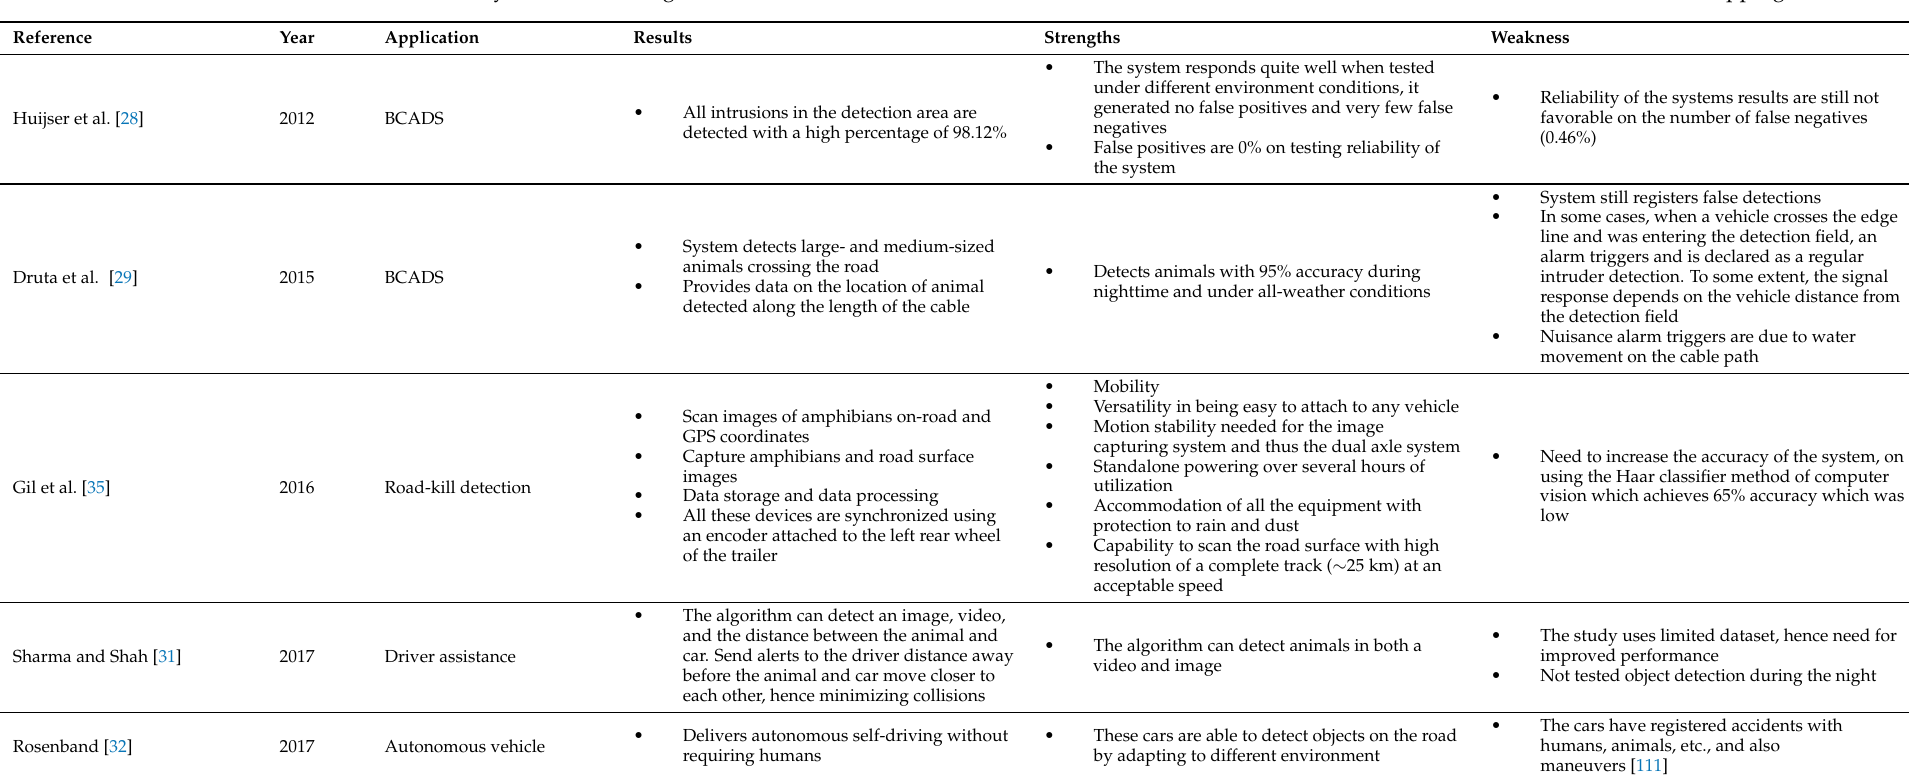
Table 7. Summary of results, strengths, and weaknesses of BCADS, roadkill detection, driver assistance, autonomous vehicles, and mobile mapping